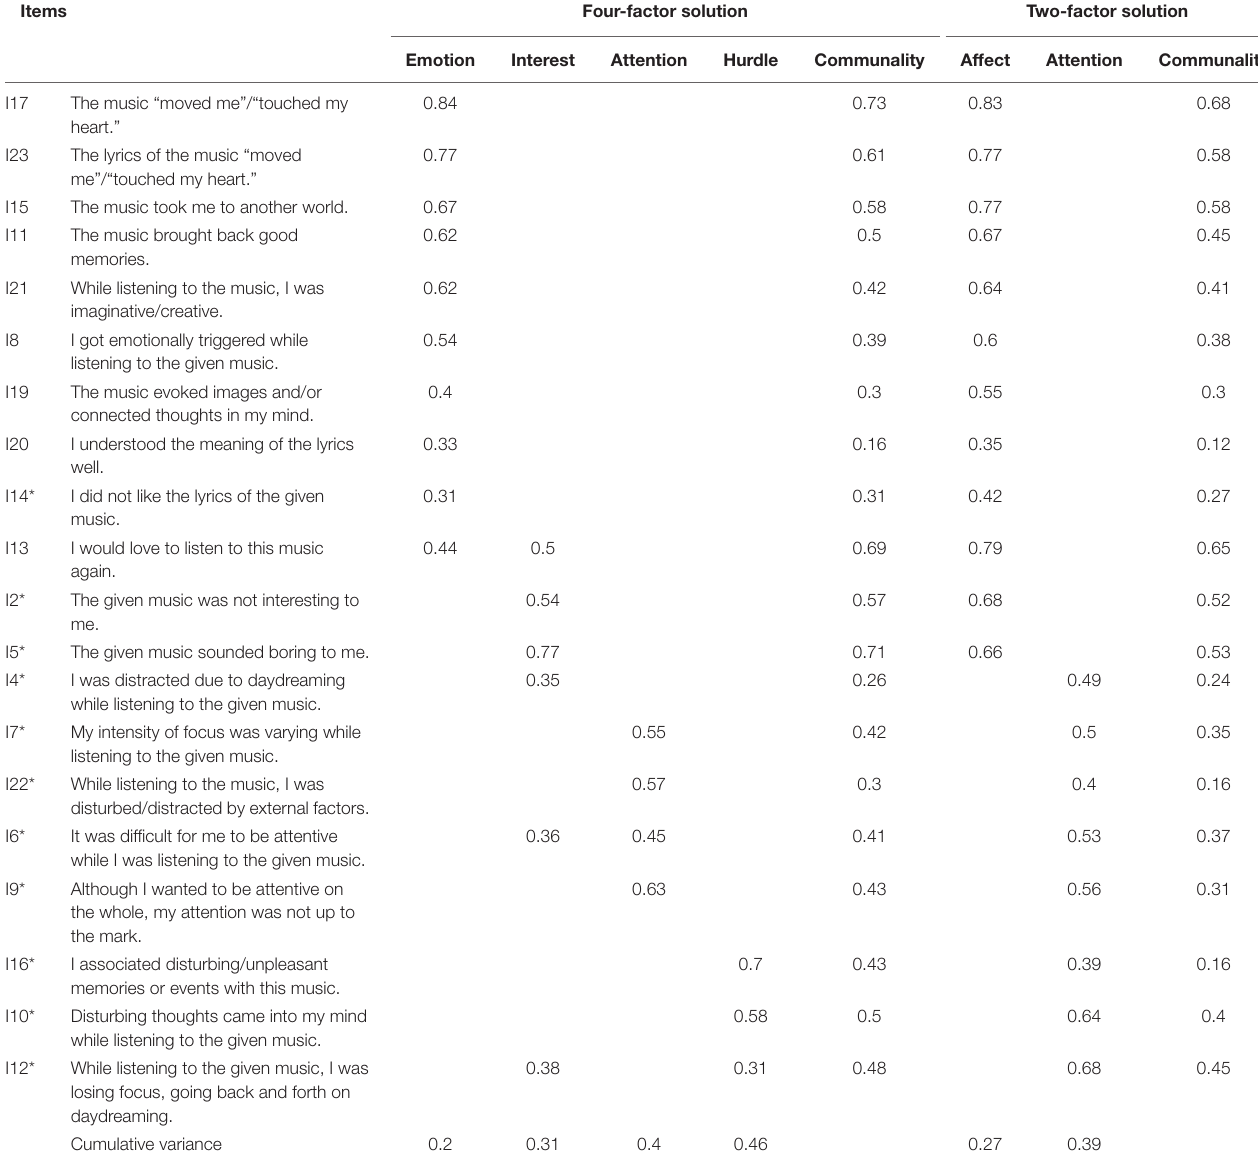
TABLE 1 | Exploratory factor analysis showing the factor loadings from the pattern matrix for the 20-item MRS scale ( n = 313), with four-factor and two-factor